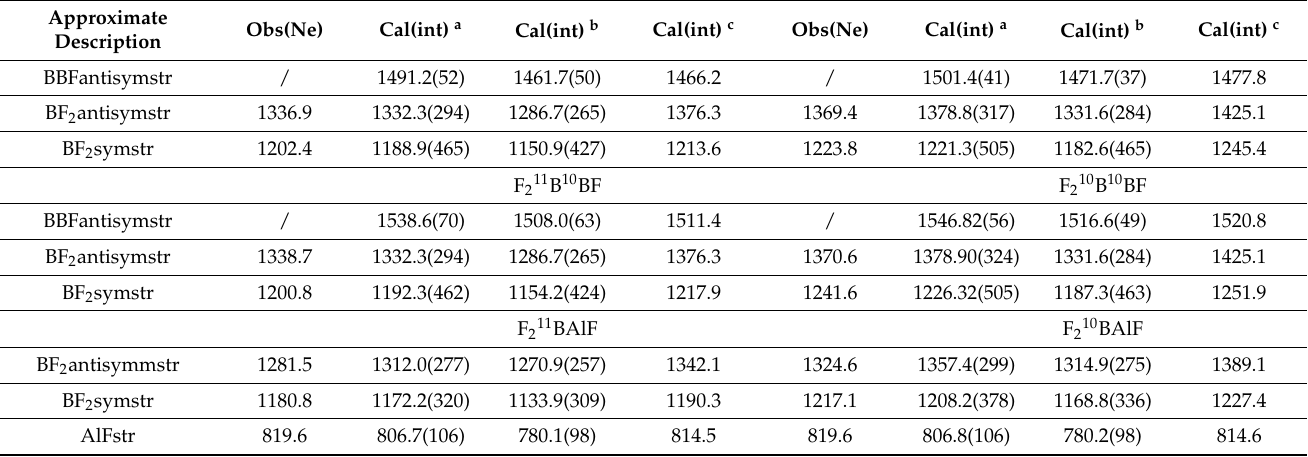
Table 1. Observed and calculated fundamental frequencies of F 2 BBF and F 2 AlBF isotopomers in the ground 2 A